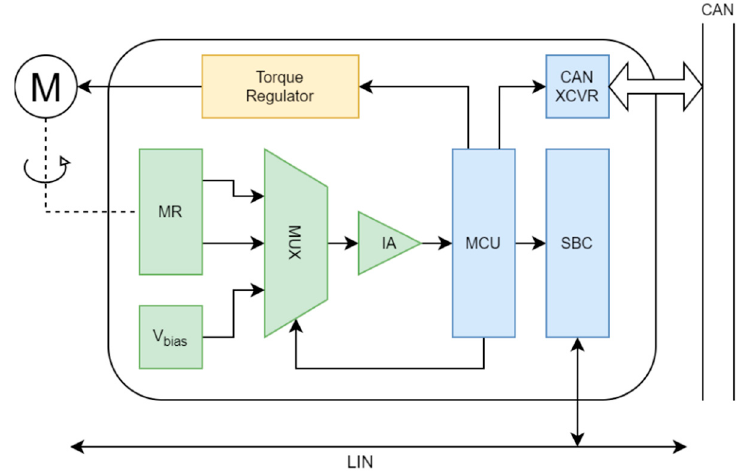
Figure 6. Block diagram of measurement device.